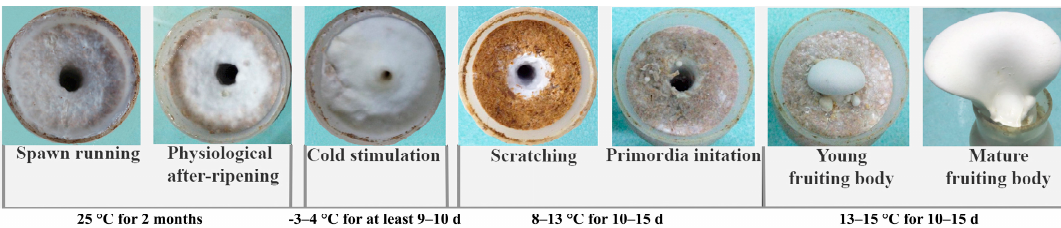
Figure 1. Developmental stages of Bailinggu in year-round mushroom factory cultivation cycles. The vegetative (spawning, physiological ripening, cold stimulation) and fructification (primordia, fruiting body) phases are shown.